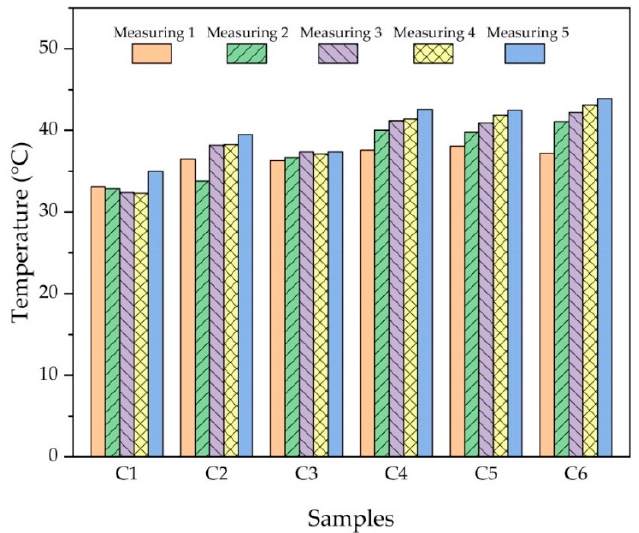
Figure 14. Average friction coefficient of samples produced at different ratios. Figure 15 represents the temperature graph generated during the wear tests. Tem- peratures were recorded by measuring every 200 m of wear distance. When the graph is inspected, it is clear that the rising temperatures are directly proportional to the rein- forcement ratios. It was observed that the temperature also increased in each measure- ment interval. The highest temperature was recorded as 41.4 °C in sample no C6 (Cu-6Gr/3SiC-3WC). The fact that the C6 sample has the highest average friction coeffi- cient supports this situation (highest temperature). As the friction coefficient increases, the temperature also increases.